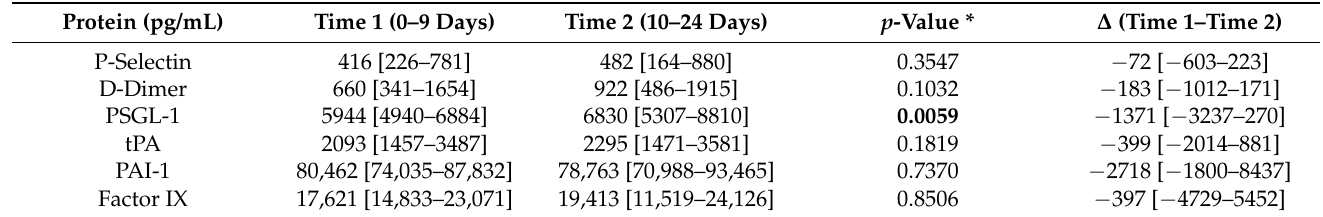
Table 5. Two-time determination of coagulation proteins in patients with severe COVID-19 ( n =